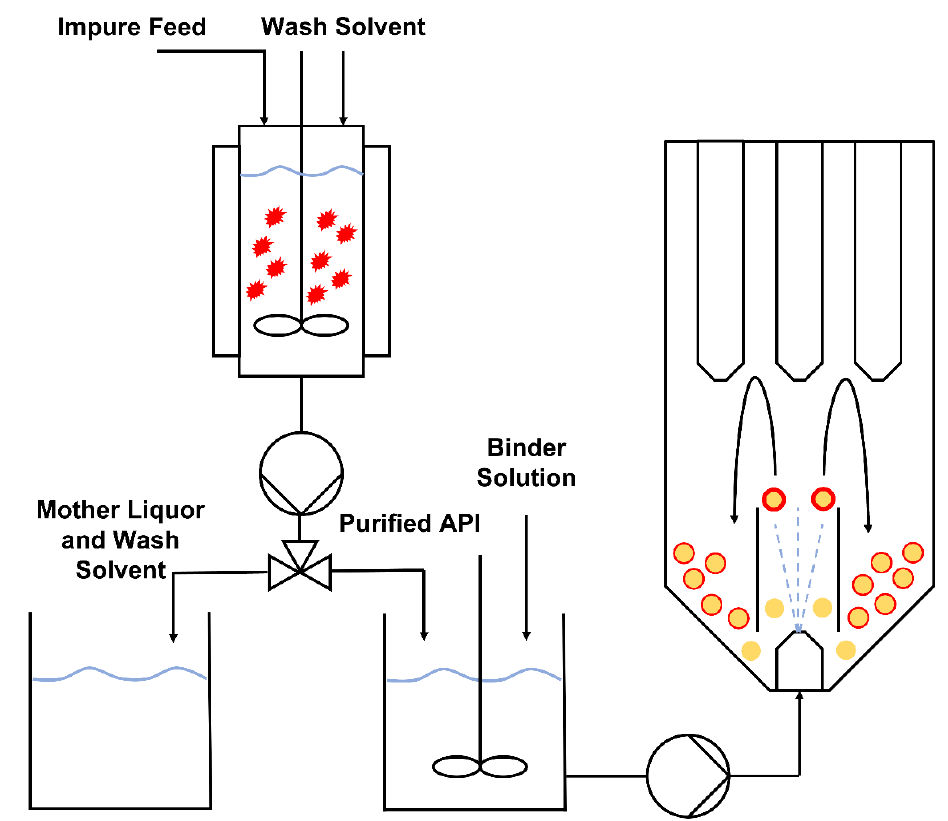
Figure 2. Process flow diagram of the combined crystallization and fluidized bed-coating processes.